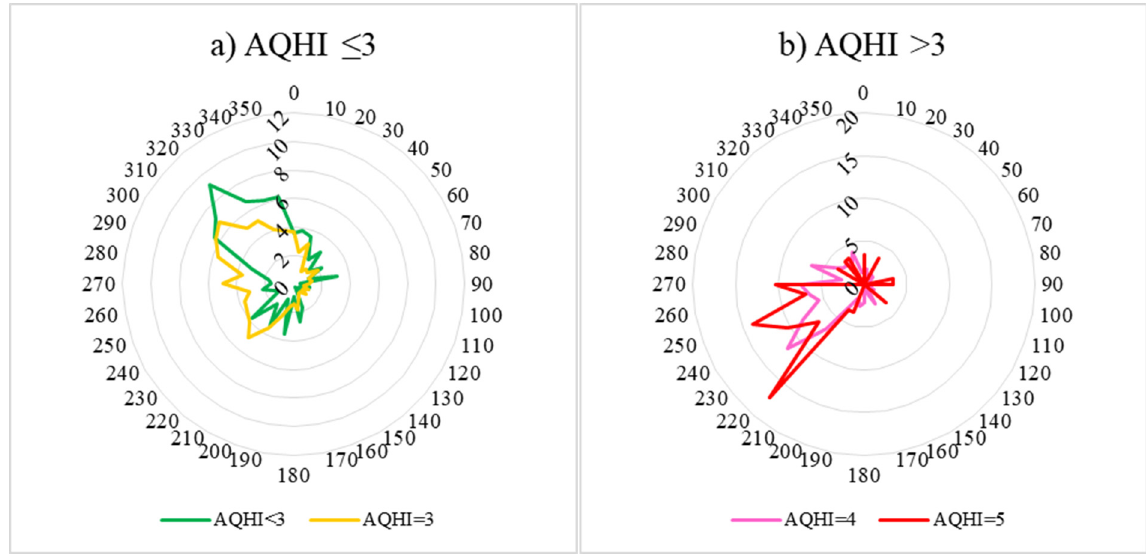
Figure 3. Percentage distribution (on vertical axis) of air-mass direction in each AQHI group.